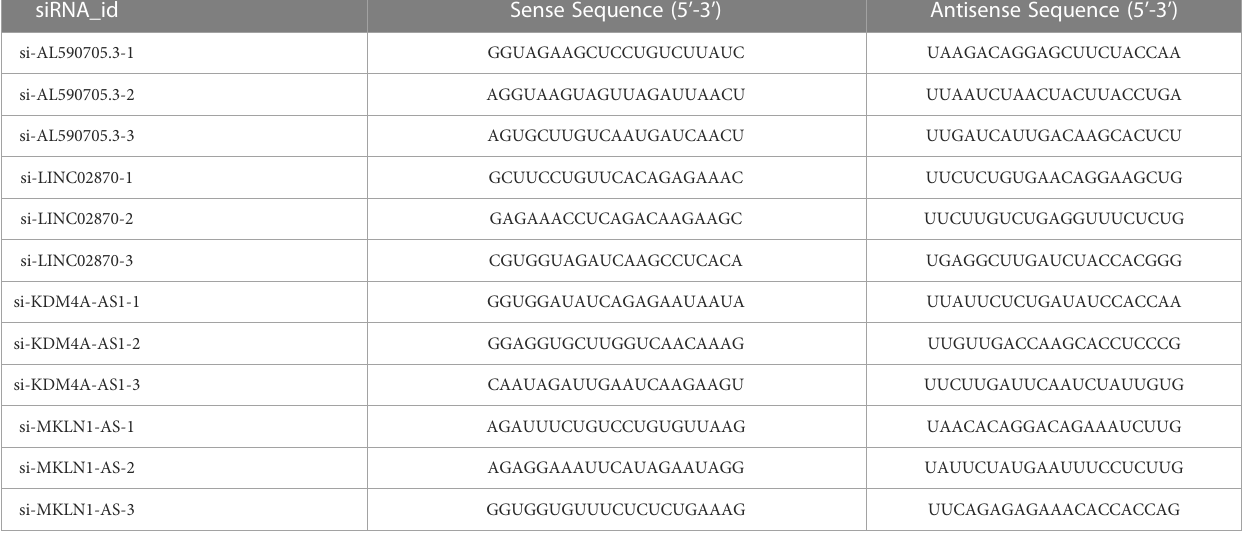
TABLE 1 The siRNAs